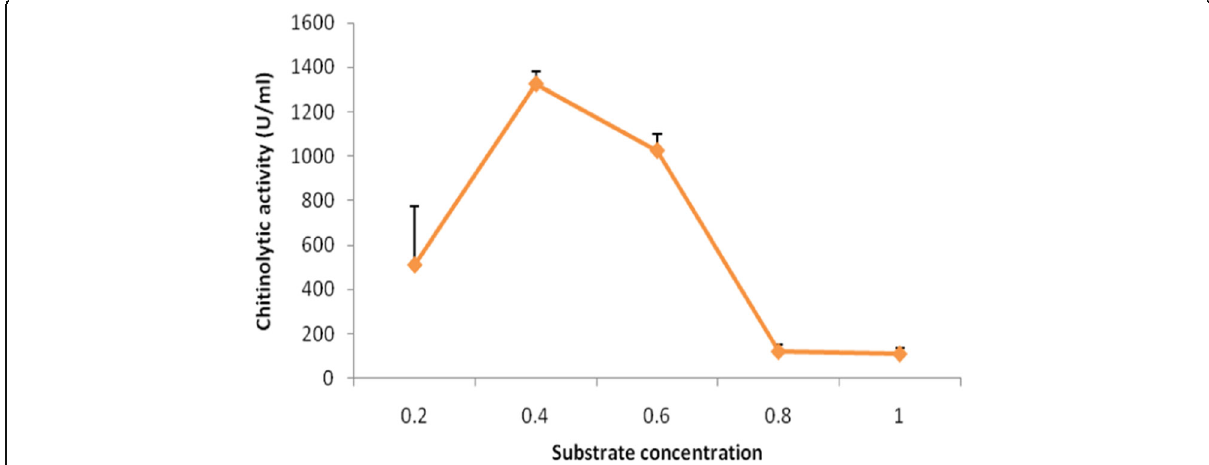
Fig. 7 Effect of substrate concentration on chitinase activity of S . maltophilia JF66, grown at optimized